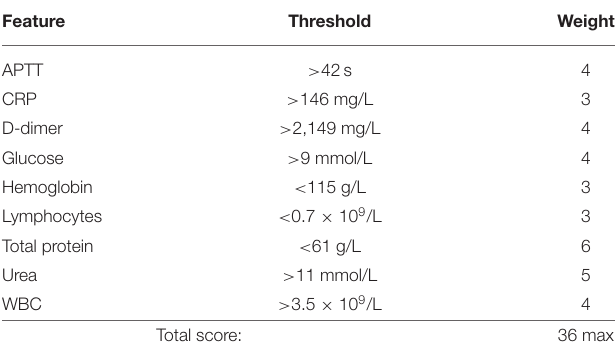
TABLE 2 | The proposed score